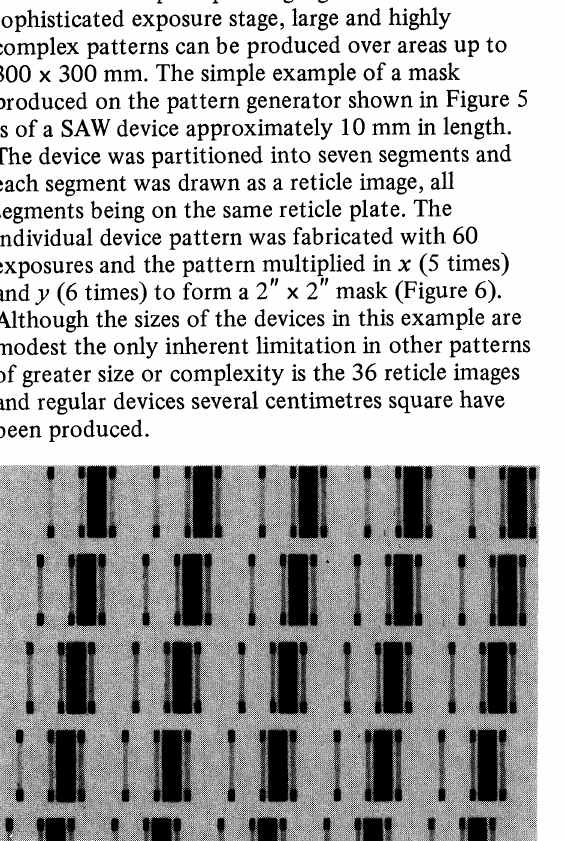
FIGURE 6 Multiple image mask produced at final size without step and